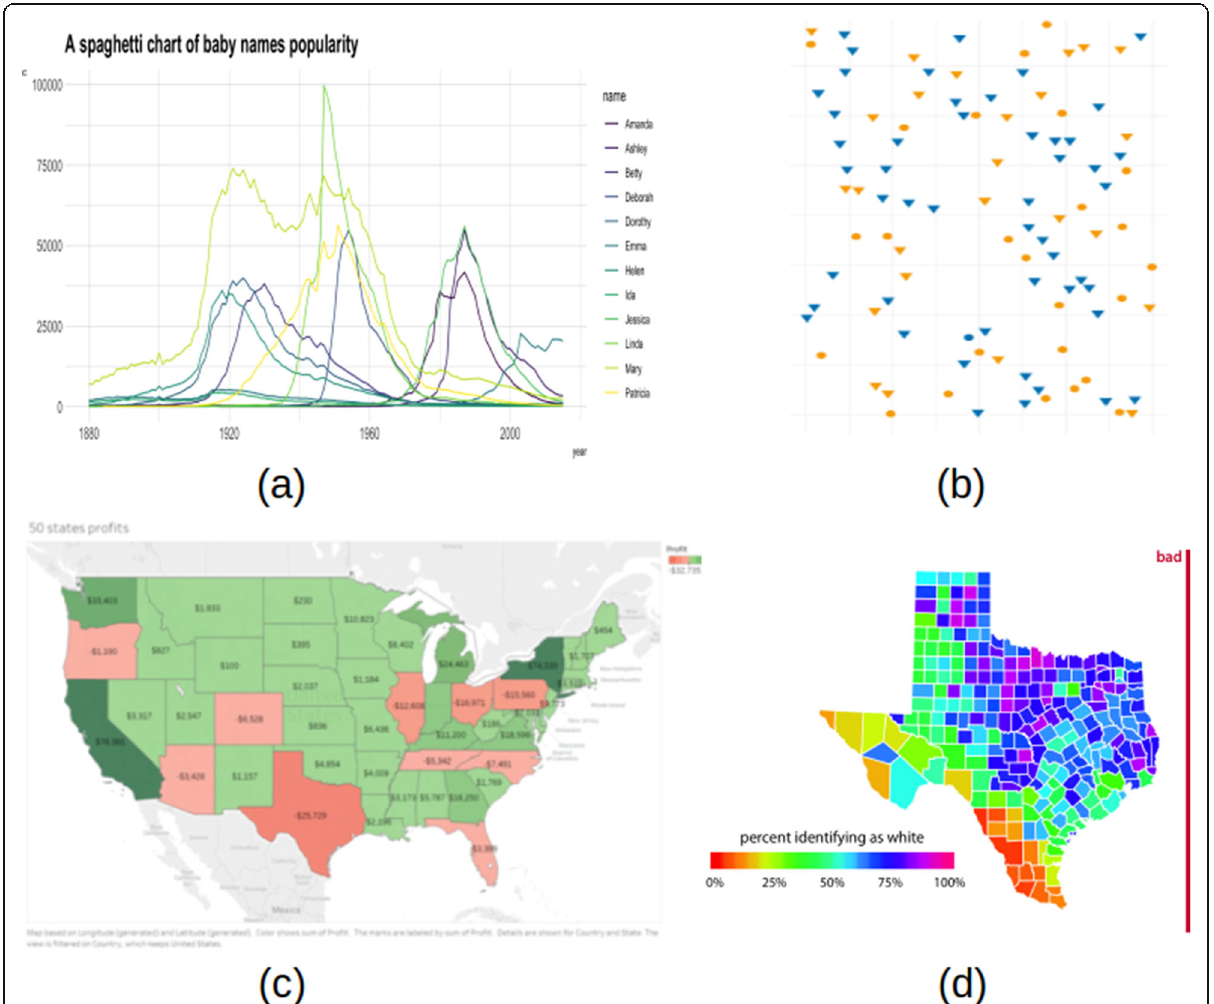
Fig. 6 Misinformation due to color violation: a using too many colors [36], b unnecessary color usage [37], c color against the norm [38] and d rainbow color scale